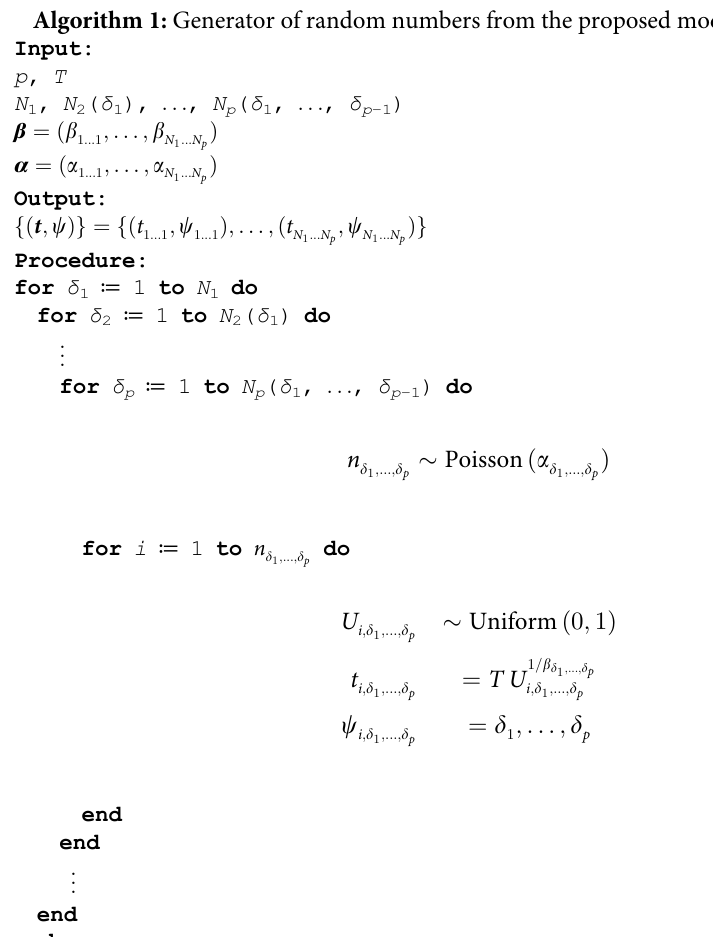
Algorithm 1: Generator of random numbers from the proposed